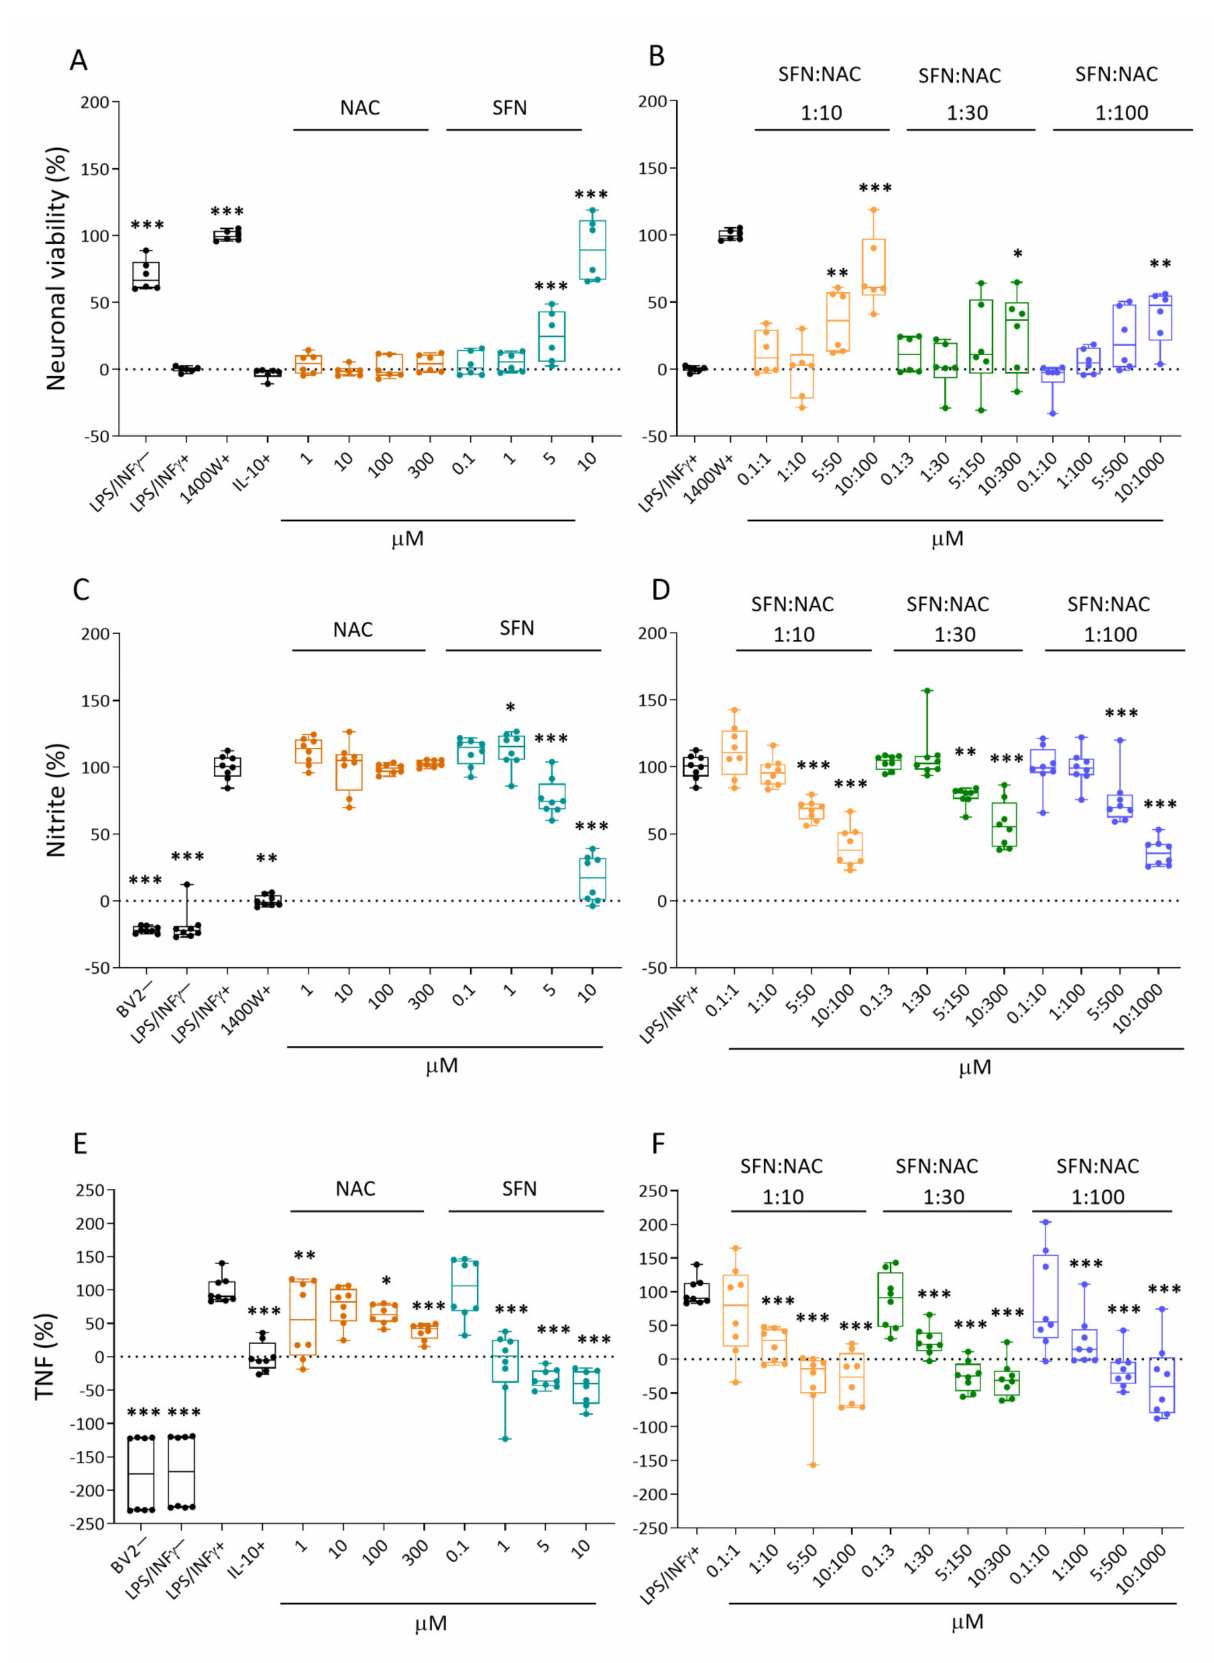
Figure 2. Effect of NAC or SFN monotherapy and SFN+NAC duotherapy on neuronal viability, and nitrite and TNF levels in cortical neuron-BV2 co-cultures in vitro. ( A ) Monotherapy with NAC did not affect the LPS/INF γ + -induced cell